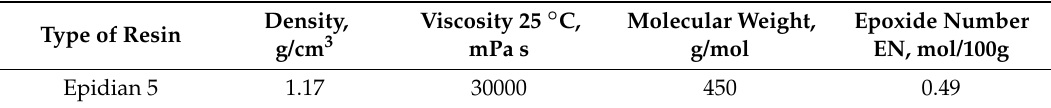
Table 1. Selected parameters characterizing Epidian 5 epoxy resin.